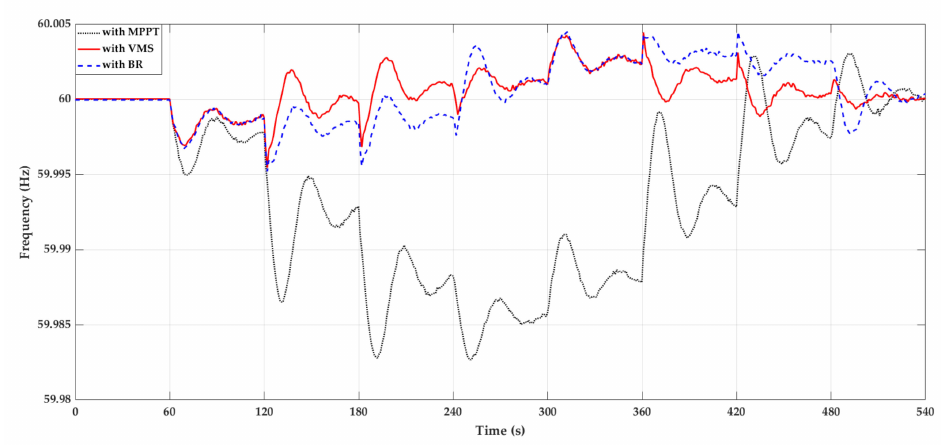
Figure 7. The frequency responses according to the CBG’s control mode.